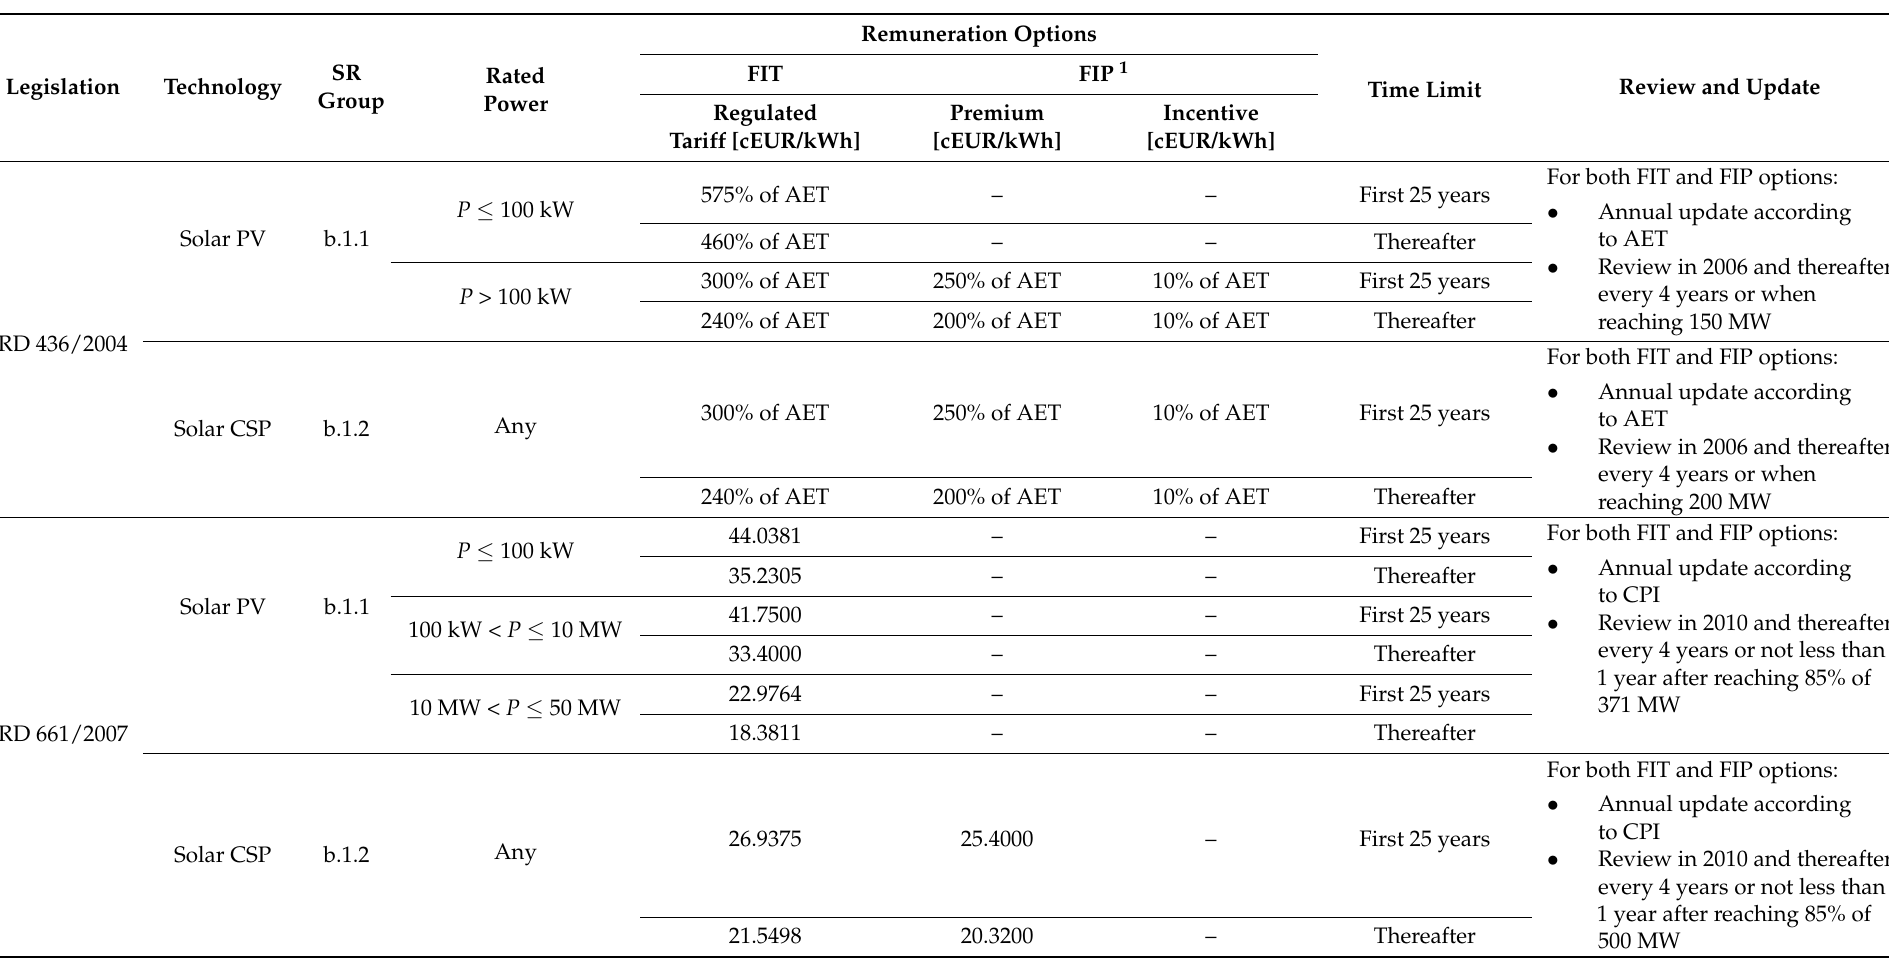
Table 4. Major characteristics of the different economic regimes in force for solar power systems in Spain in the period 2004–2008. Source: self-elaboration based on